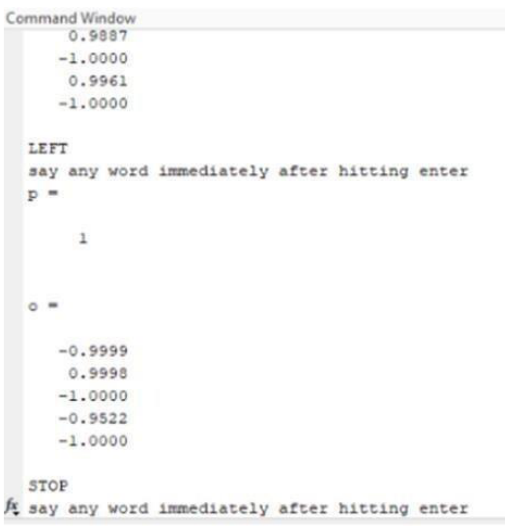
Fig. 4 Speech to text on MATLAB